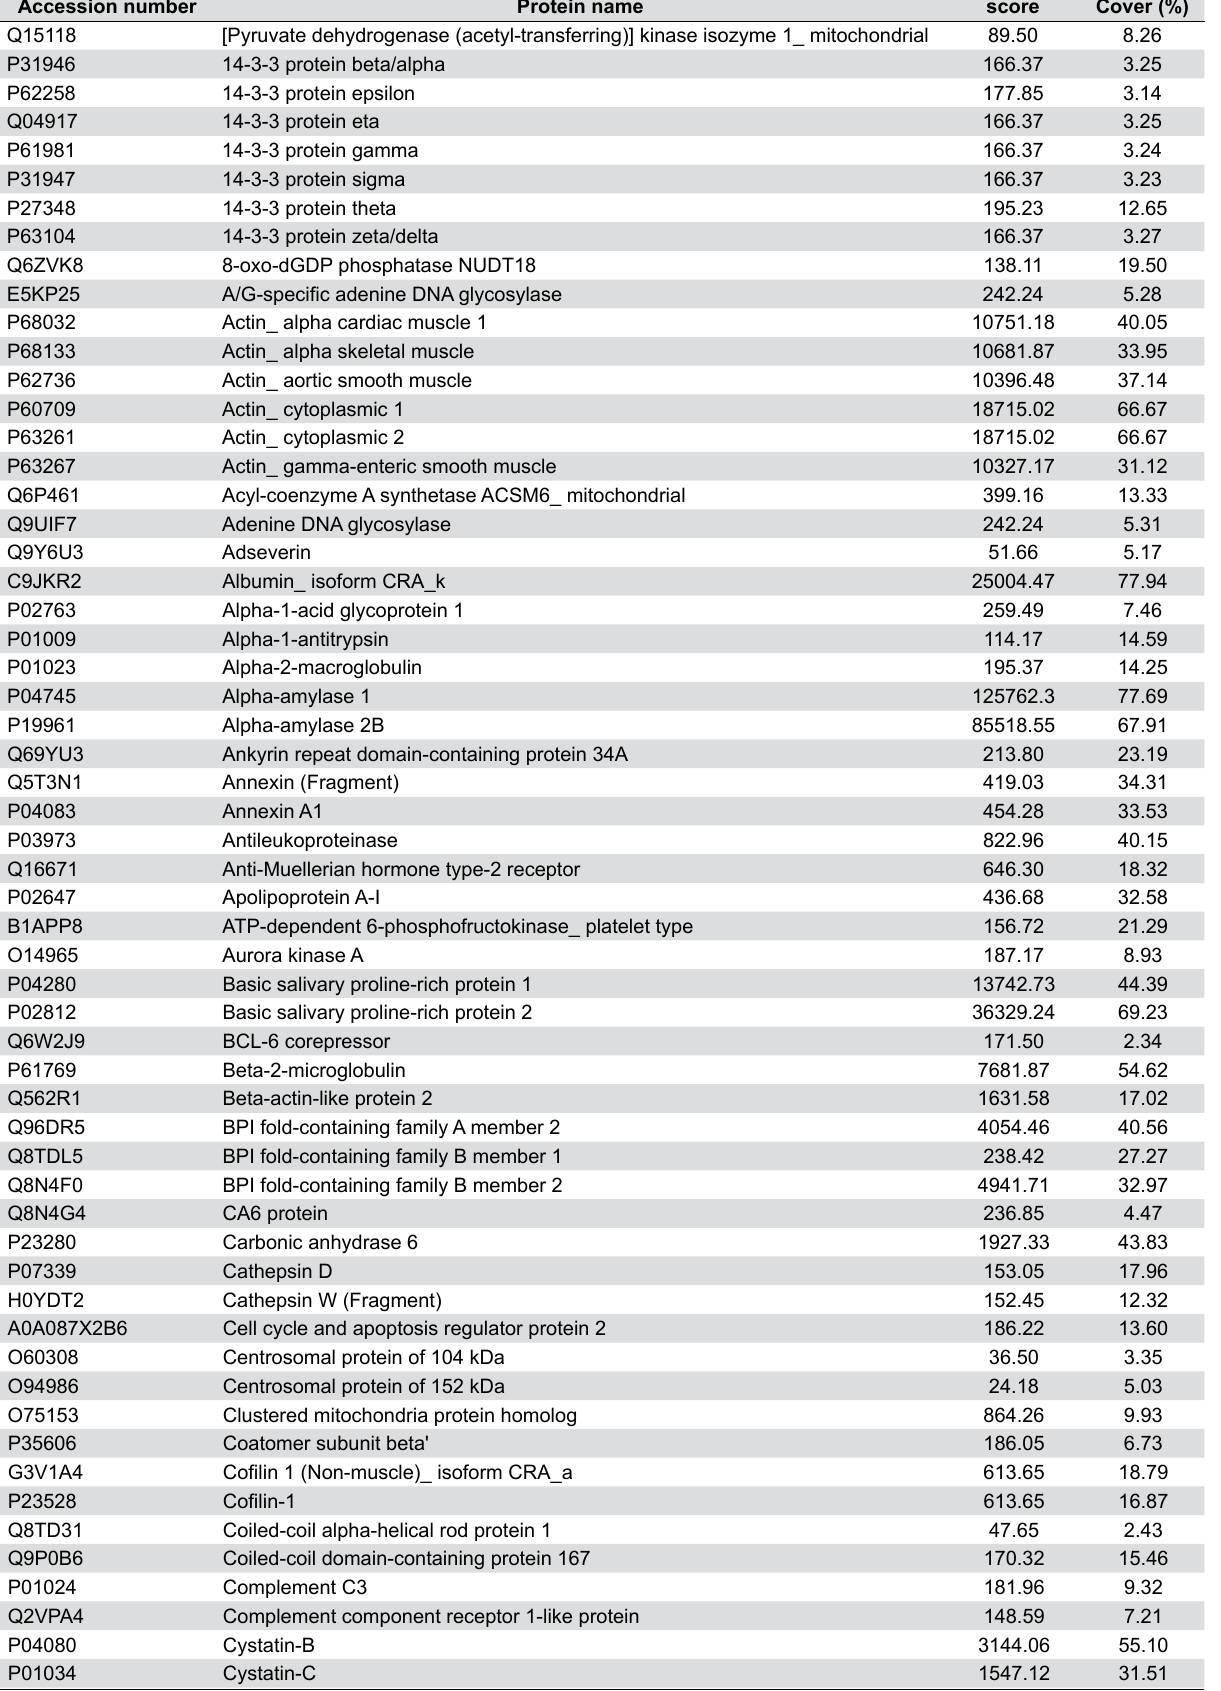
Table 2- Salivary proteins identified when the albumin and IgG depletion column was not